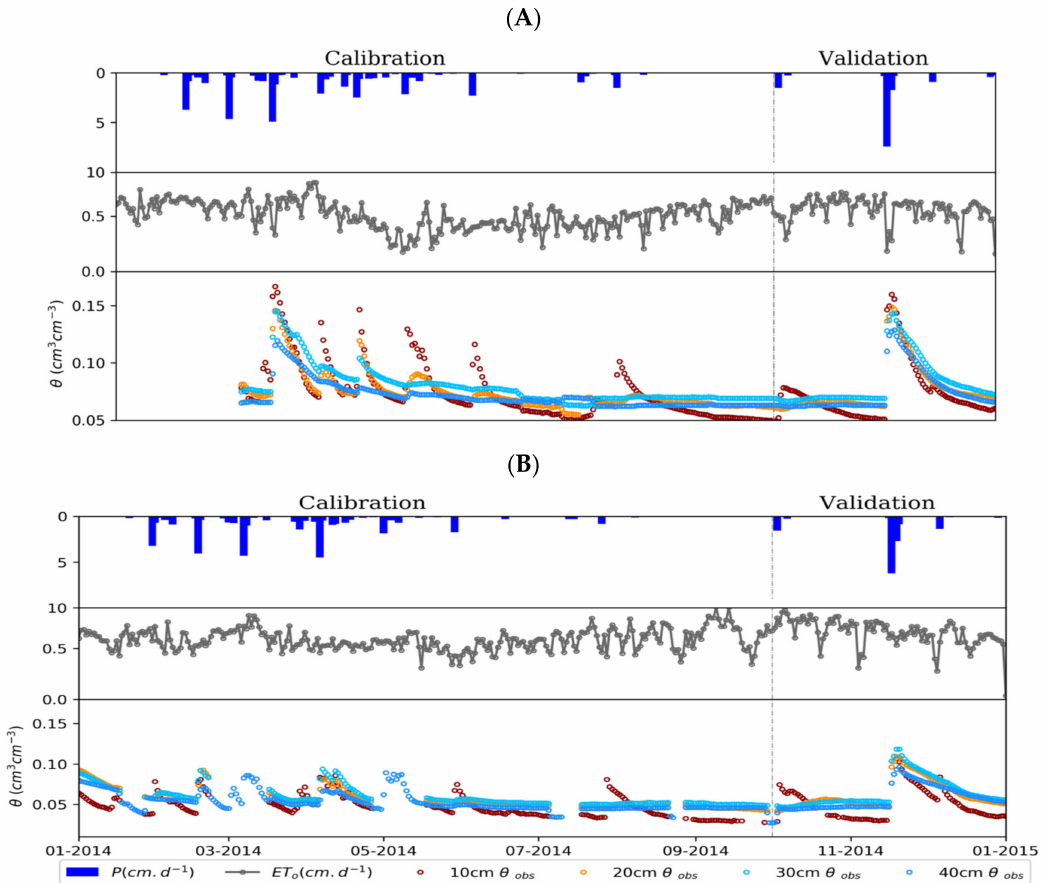
Figure 5. Temporal distribution of soil moisture and rainfall nearby the BR-CST ( A ) and BR-GST ( B )